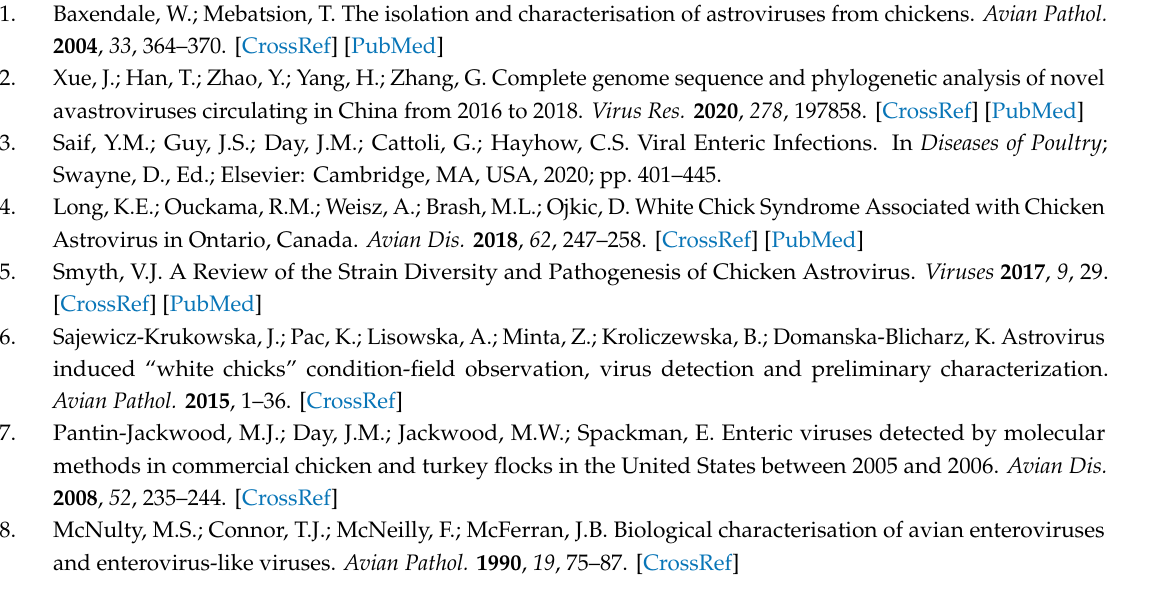
Table S1: Genome Sizes of complete CAstV Sequences; Figure S1: Amino acid ML phylogenetic tree of ORF1a; Figure S2: Amino acid ML phylogenetic tree of ORF1b; Figure S3: Nucleotide ML phylogenetic analyses on CAstV on each of the recombination events described on Table 2; Figure S4: Amino acid ML phylogenetic tree of a total of 83 partial ORF2 CAstV sequences; Figure S5: Percentage heat map of amino acid identity obtained from ML phylogenetic tree described on Figure